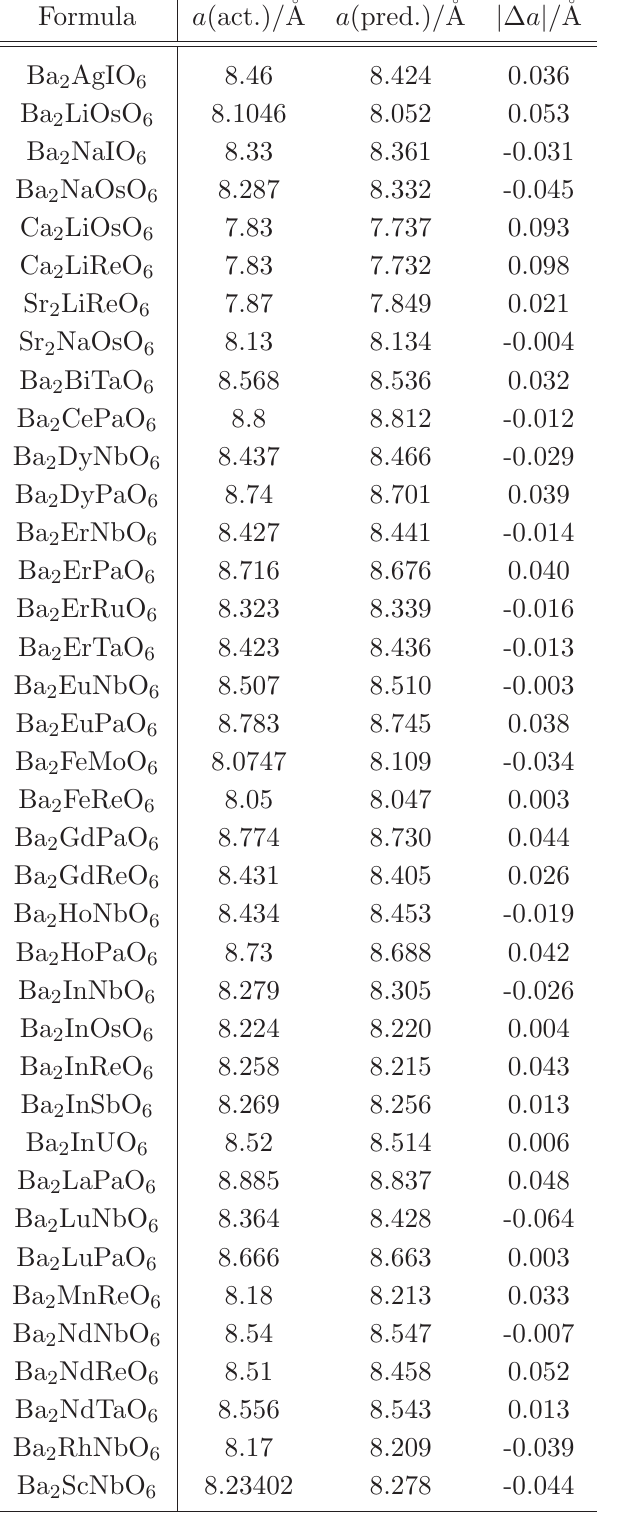
Table 3 Actual, predicted values for the unit cell length, as well as, absolute errors for the compounds of the calibration set obtained by